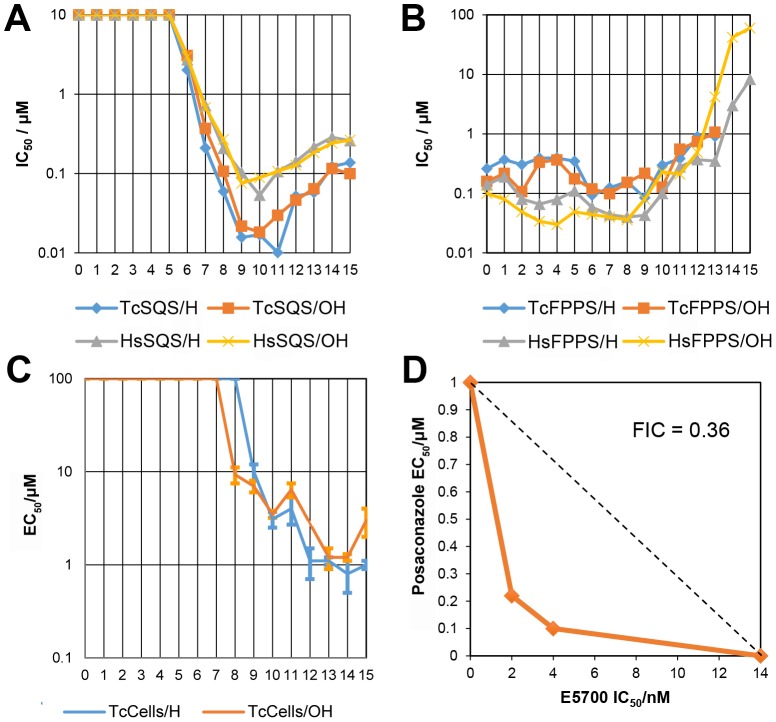
Enzyme and cell growth inhibition results.(A) TcSQS and HsSQS inhibition by bisphosphonates as a function of n, the number of carbons in the n-alkyl group. For n<6, the IC50 values are larger than 10 µM; (B) As (A) but for TcFPPS and HsFPPS. (C) T. cruzi amastigote cell growth inhibition by bisphosphonates as a function of n. (D) Isobologram showing the synergistic effect of E5700 and posaconazole against T. cruzi amastigotes after 96 h of treatment. Dashed line corresponds to the predicted positions of the experimental points for additive effects.